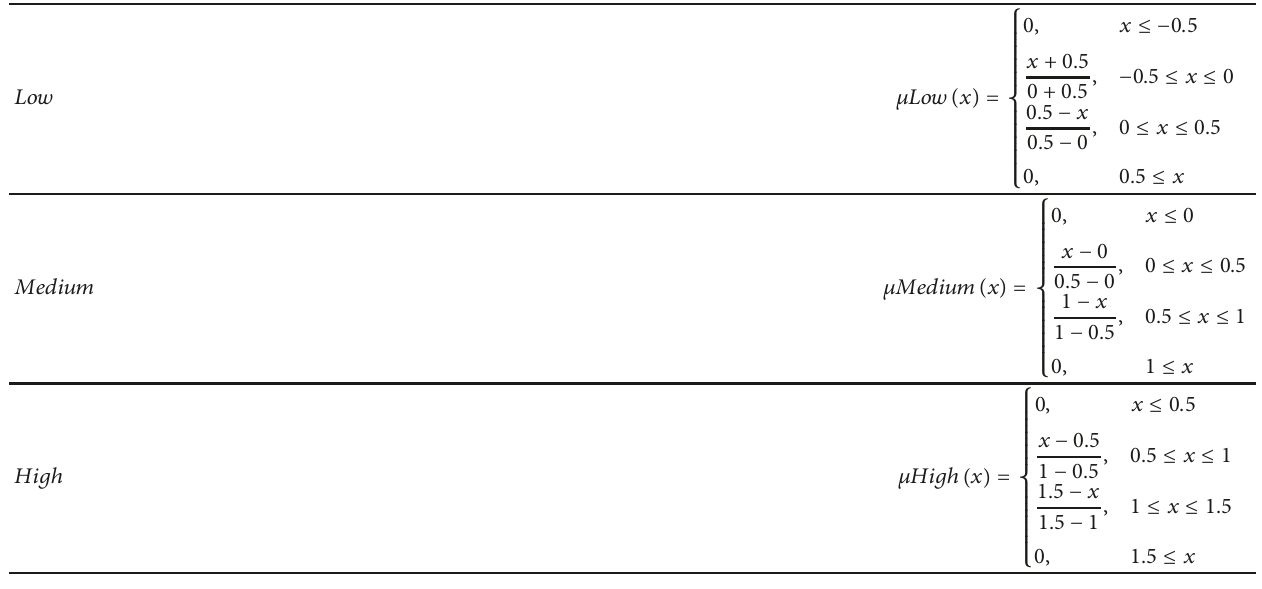
Table 1: Type-1 membership functions for the input and output variables.